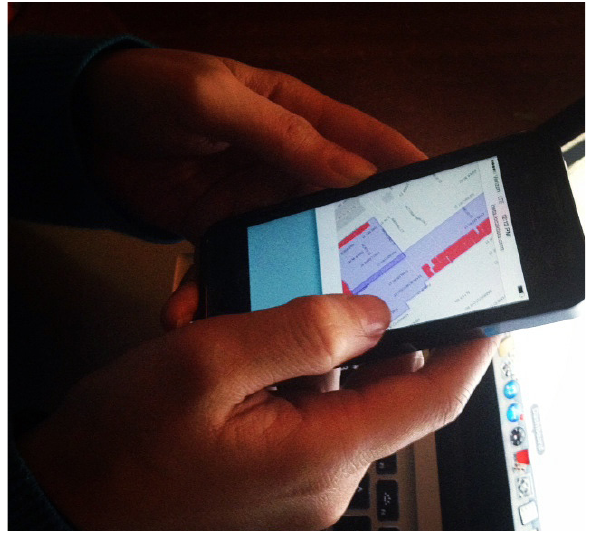
Figure 2. DHRS surveyor using her smartphone to monitor survey results coming in from other surveyors in the field (Photo Credit: Amy Elliott Bragg)